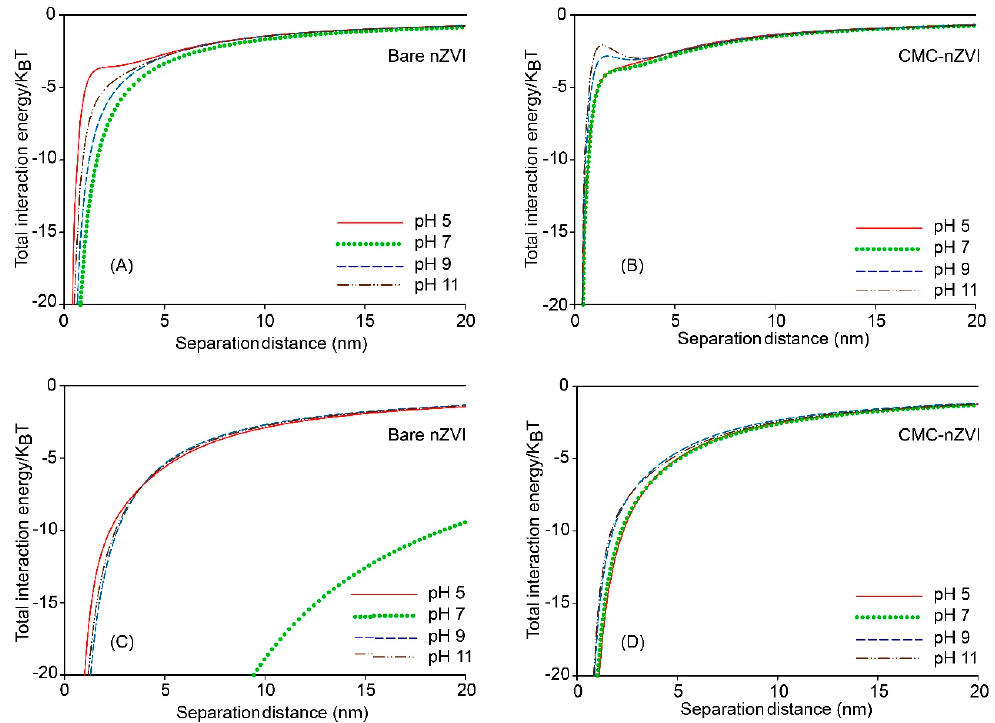
Figure 9. Effect of pH and CMC polymer stabilizer on the total interaction energy of 0.1 g L − 1 (A,B) and 1.0 g L − 1 (C,D) nZVI particle suspensions in 100 mM NaHCO 3 .